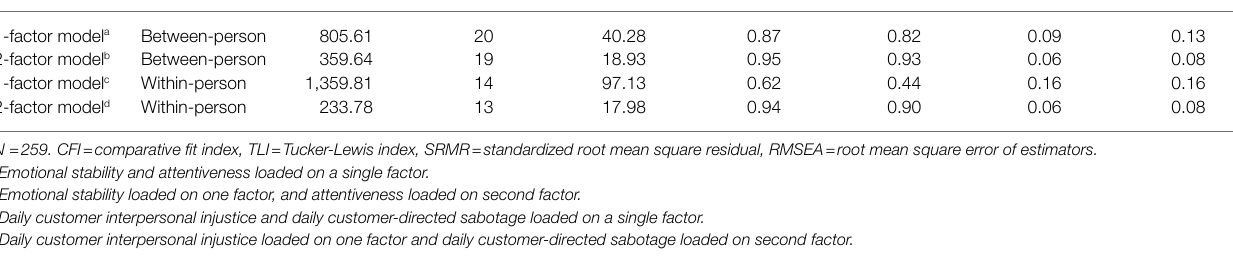
TABLE 2 | Fit Indices for alternative measurement models (Study 3). Measurement